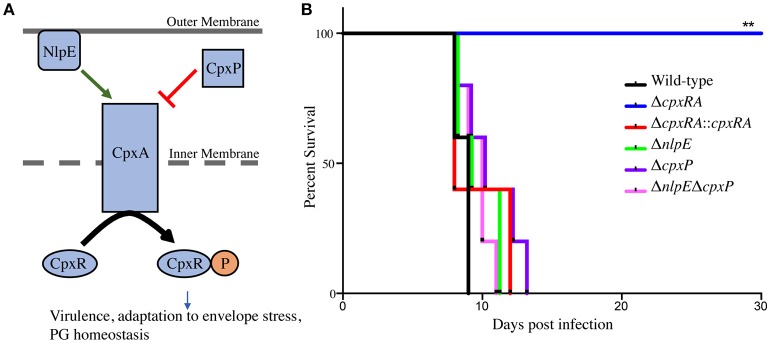
Survival of susceptible mice after infection with Cpx TCS mutant strains of Citrobacter rodentium. (A) TCSs are used by bacteria in order to sense environmental stress. The membrane bound histidine kinase (CpxA) is activated by an external signal and propagates a cascade of phosphorylation leading to a transcriptional response by the cytoplasmic response regulator (CpxR). The Cpx TCS has a reported upstream outer membrane sensor, NlpE, and a periplasmic inhibitor, CpxP. (B) Female C3H/HeJ mice were infected by oral gavage with 2–3 × 108 colony forming units of wild-type C. rodentium, or a TCS mutant strain. Survival was monitored for 30 days post infection. The log-rank (Mantel-Cox) method was used to determine statistical significance. (PG - peptidoglycan), (**P < 0.01, n = 5).